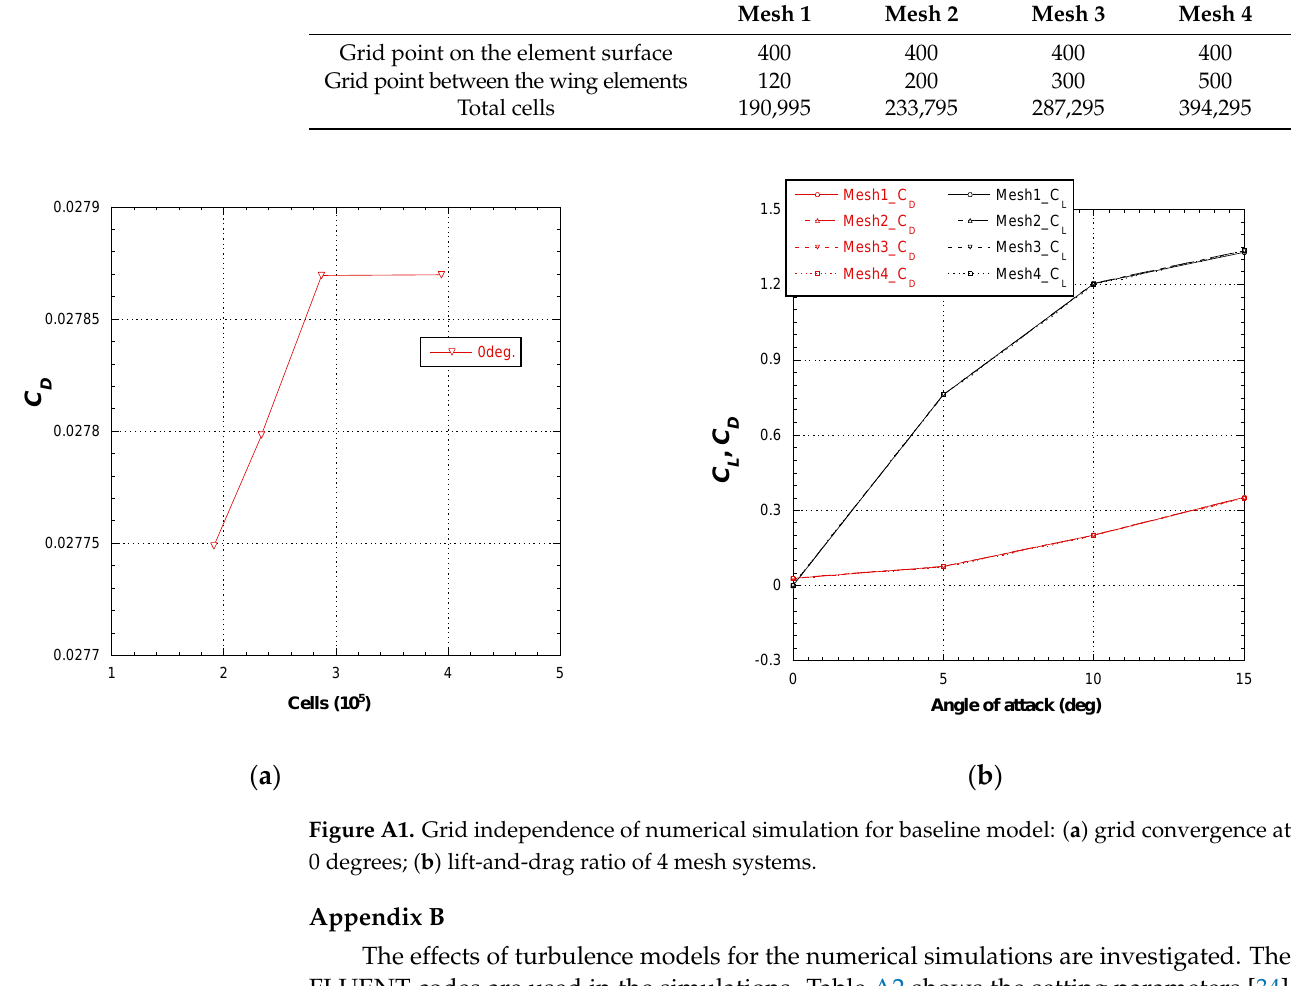
Table A2. The simulation